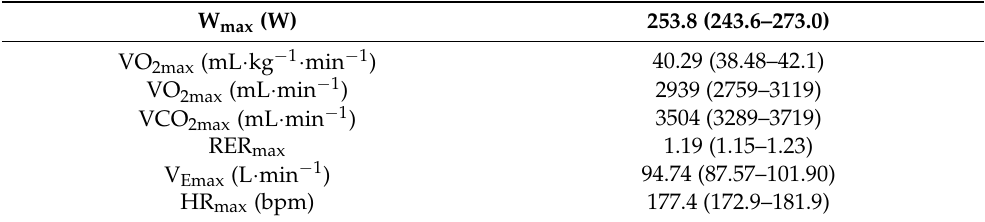
Table 1. Mean with 95% confidence interval of metabolic data at maximum workload (W max ) collected during the cardiopulmonary test. N =